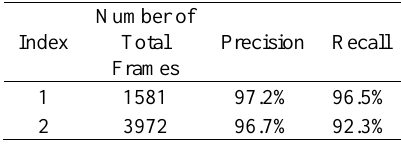
Table 2. Computational Time Analysis